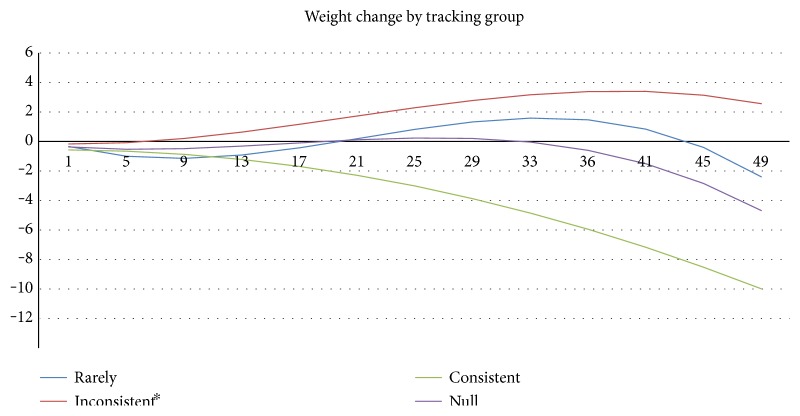
Predicted weight loss, in pounds, over time across tracking groups, from week 2 to week 49, holding all other variables constant. Inconsistent curve is not statistically different from the rare curve. Week 9 is the thanksgiving week and the beginning of the holiday season, and weight begins to climb. Week 33 is the beginning of summer (June), and we see weight start to drop again. However, consistent trackers do not experience these changes and sustain steady weight loss throughout the year. ∗Nonsignificant.